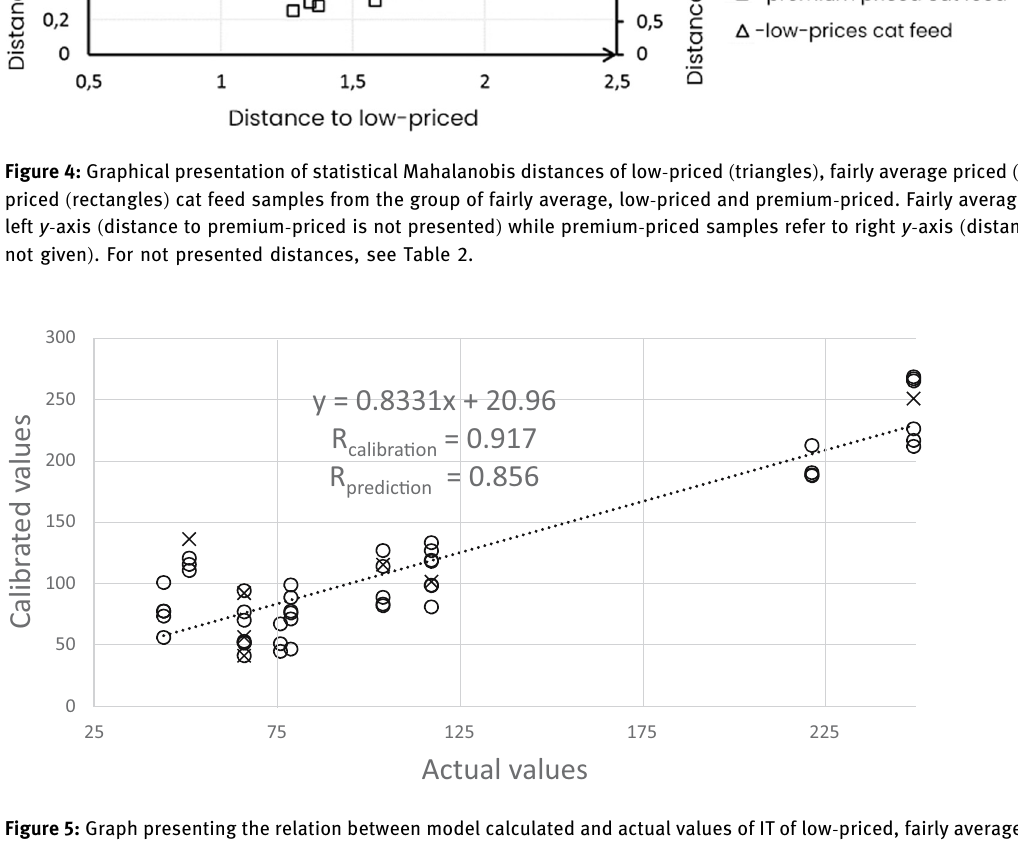
Figure 5: Graph presenting the relation between model calculated and actual values of IT of low - priced, fairly average priced and premium - priced cat feeds. Circles denote calibration and crosses denote